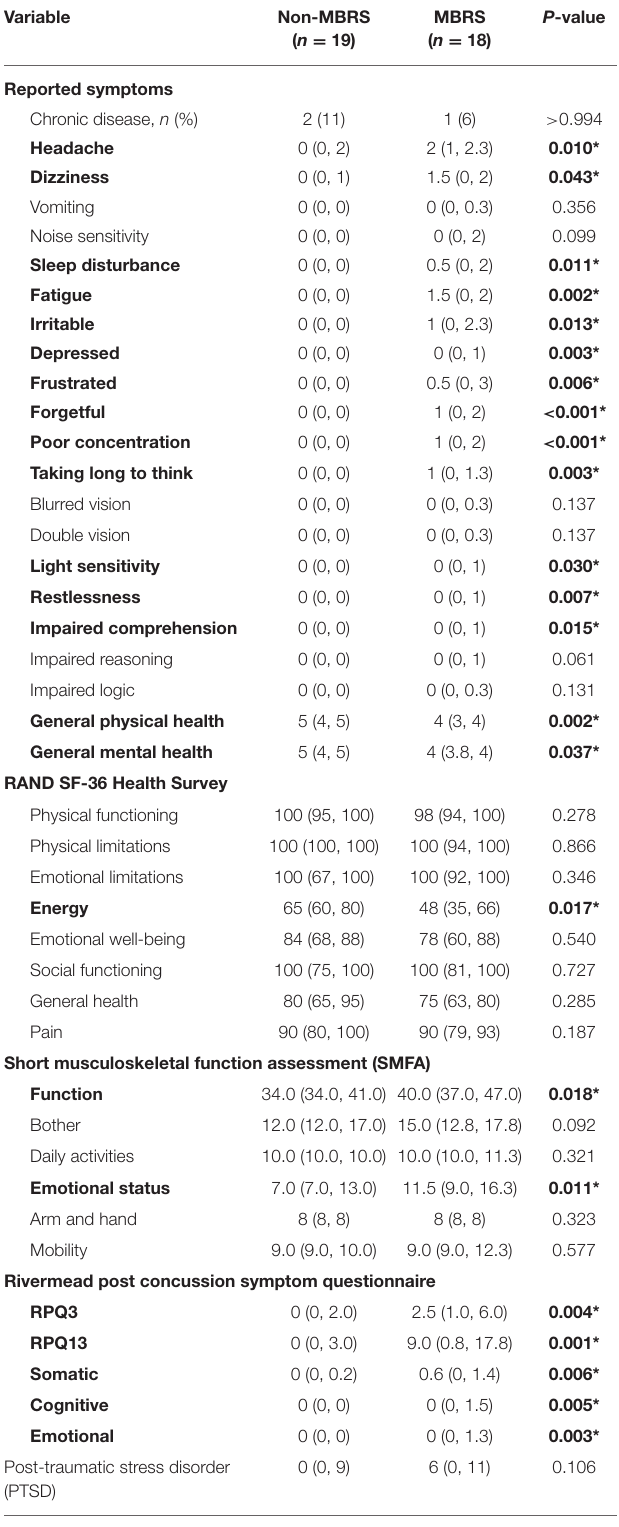
TABLE 2 | Military personnel reported symptoms and health assessment. Variable